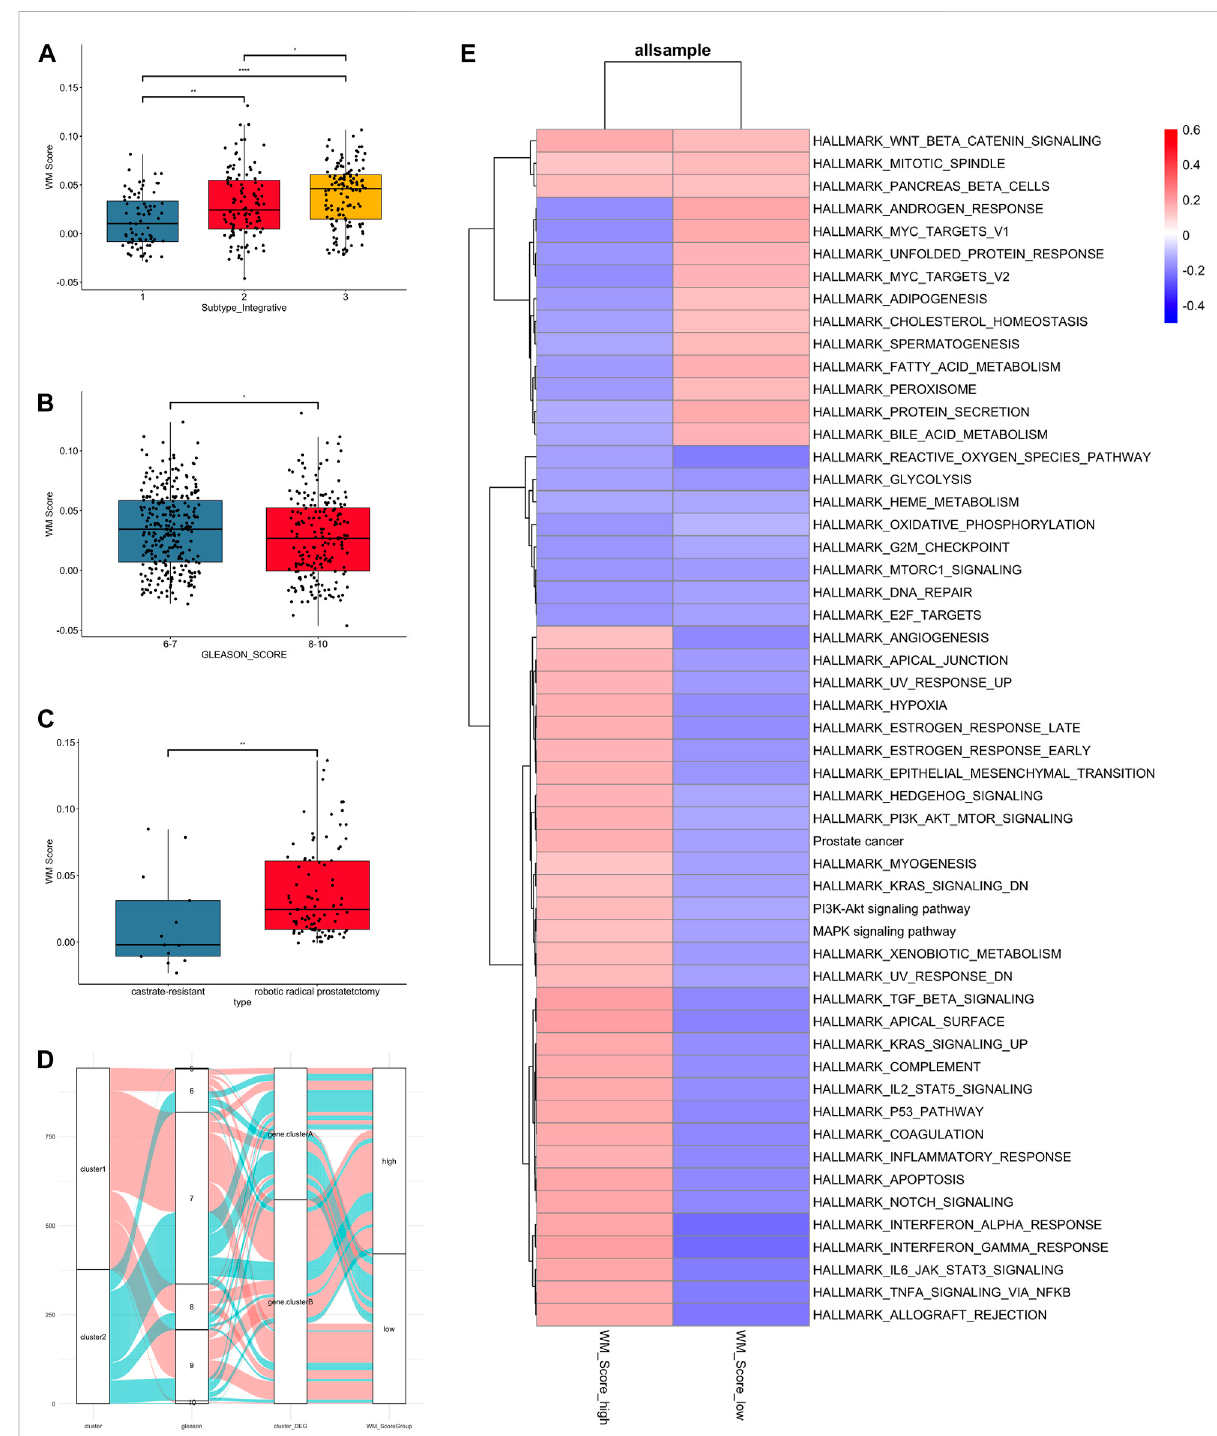
FIGURE 4 Clinical and biological characteristics of PC associated with the WM_Score. (A) WM_Score differences among TCGA molecular subtypes of PC in TCGA-RAD datasets. (B) Differences in the WM_Score between Gleason score 6-7 (blue) and 8-10 (red) group in the 3 PC cohort. (C) Differences intheWM_Scorebetweencastrate-resistant(blue)androboticradicalprostatectomy(red)groupintheGSE70770cohort.Wilcoxontestwasusedto assess the difference. The boxes indicate the median±1 quartile, with the whiskers extending from the hinge to the smallest or largest value within 1.5× IQR from the box boundaries. (D) The Sankey diagram shows the variation in the distribution of samples across these classi fi cations (E) Heatmap shows the differences in enrichment in the characteristic signaling pathways of PC subtypes between WM_Score-high and -low groups in all samples. Red, high enrichment score; blue, low enrichment